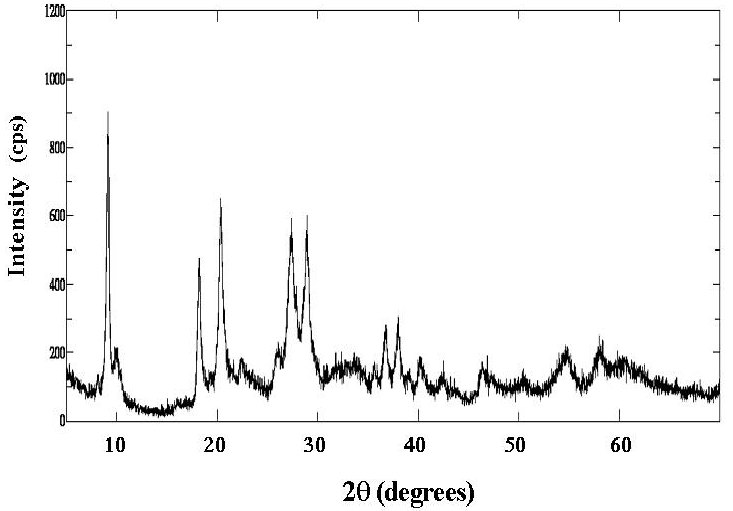
Figure 3. Differential thermal analysis (DTA) and thermo-gravimetric analysis (TGA)